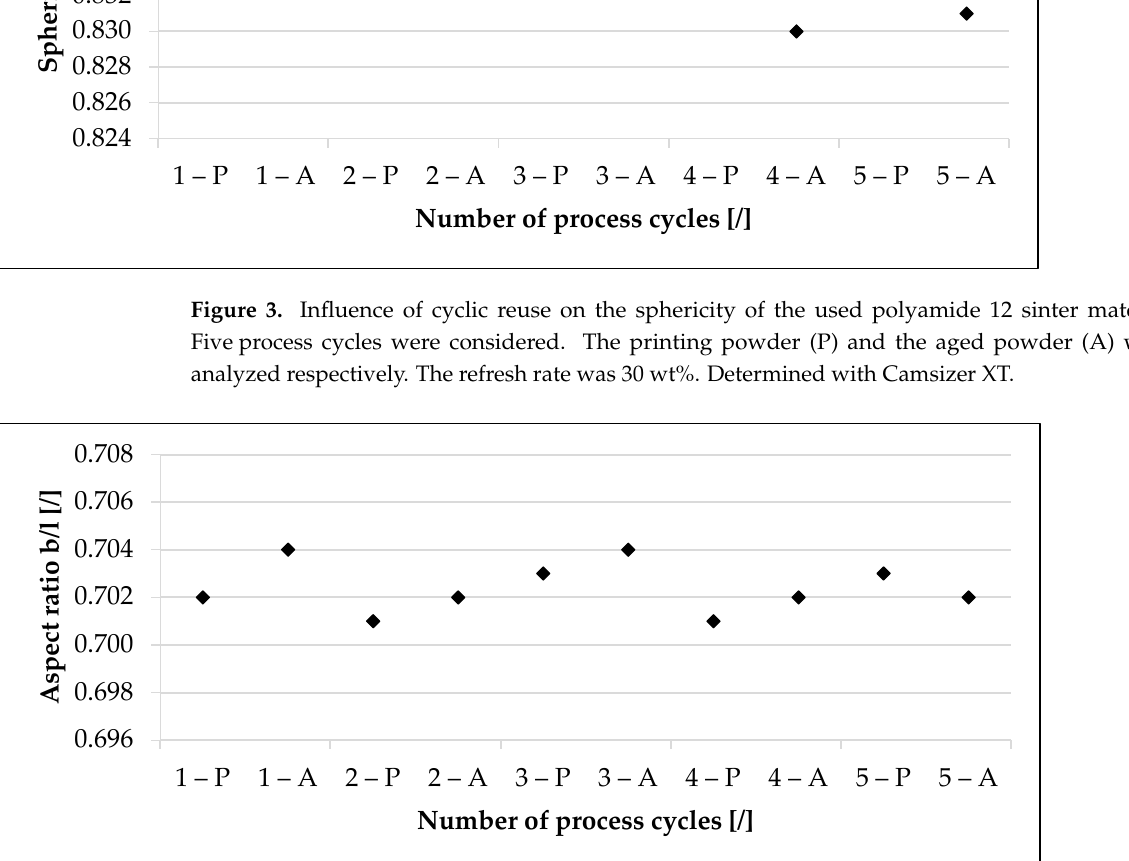
Figure 4. Influence of cyclic reuse on the aspect ratio of the used polyamide 12 sinter material. Five process cycles were considered. The printing powder (P) and the aged powder (A) were analyzed respectively. The refresh rate was 30 wt%. Determined with Camsizer XT.